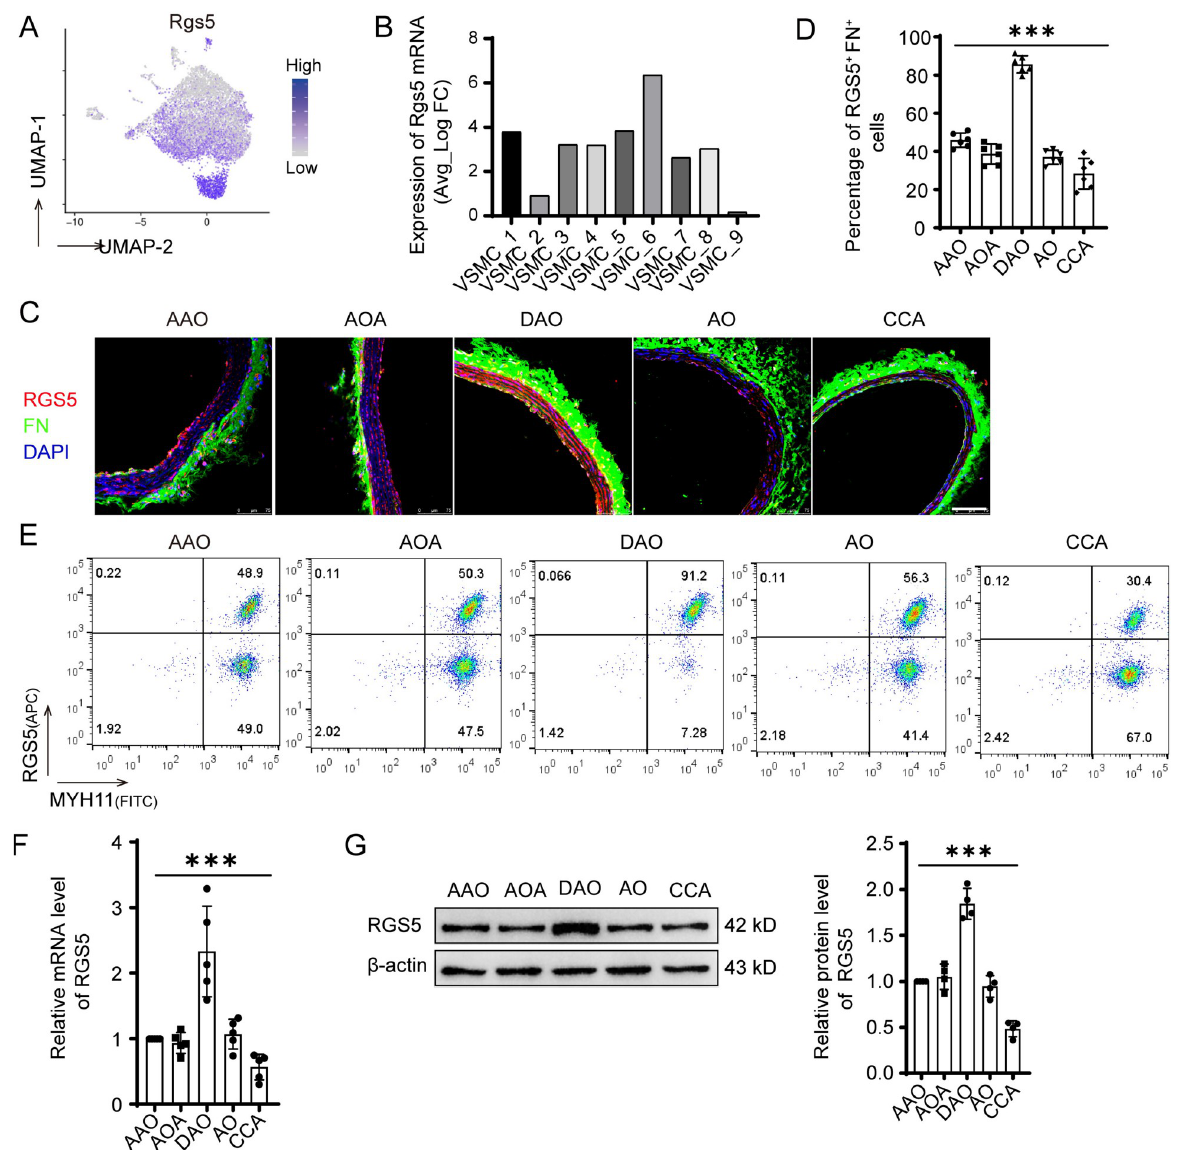
Fig 4. Distribution characterization of RGS5 high VSMC subpopulation. Spatial (A) Relative expression of RGS5 in Myh11 -expression cells. Cells were projected onto a UMAP plot. (B) Expression level of Rgs5 mRNA in each VSMC subpopulation according to the single cell RNA sequencing data. (C)Immunofluorescence microscopy images for RGS5 and FN in different aorta regions. AAO indicates the ascending aorta; AOA, aortic arch; DAO, descending thoracic aorta; AO, abdominal aorta; CCA, common carotid artery. Scale bur = 75 μ m. (D) The percentage of RGS5 + and FN + VSMCs in different aorta regions. Individual replicates and their means are indicated and error bars show s.e.m, n = 6. ��� P < 0.0001. (E) The percentage of RGS5 + and MYH11 + cells in different aorta regions analyzed by flow cytometry in different aorta regions. (F) RT-qPCR for the expression of RGS5 in different aorta regions. n = 5, ��� P < 0.0001. (G) Western blot for RGS5 expression in different aorta regions. n = 5, ��� P <